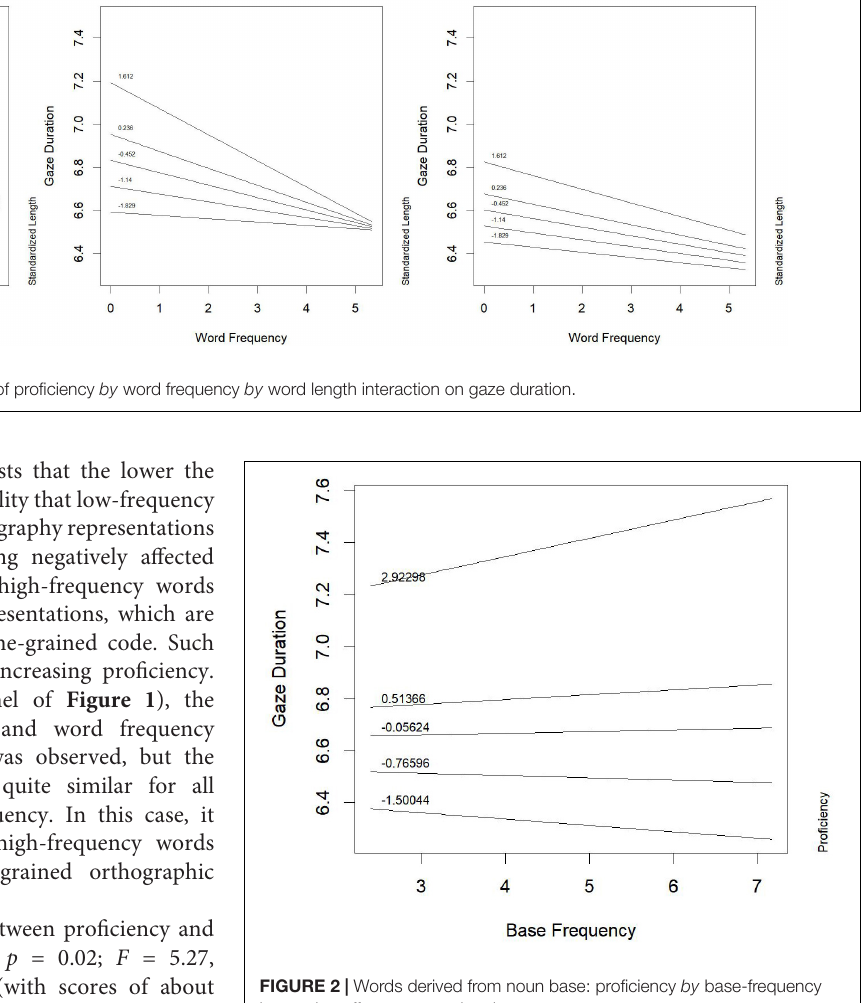
FIGURE 2 | Words derived from noun base: proficiency by base-frequency interaction effect on gaze